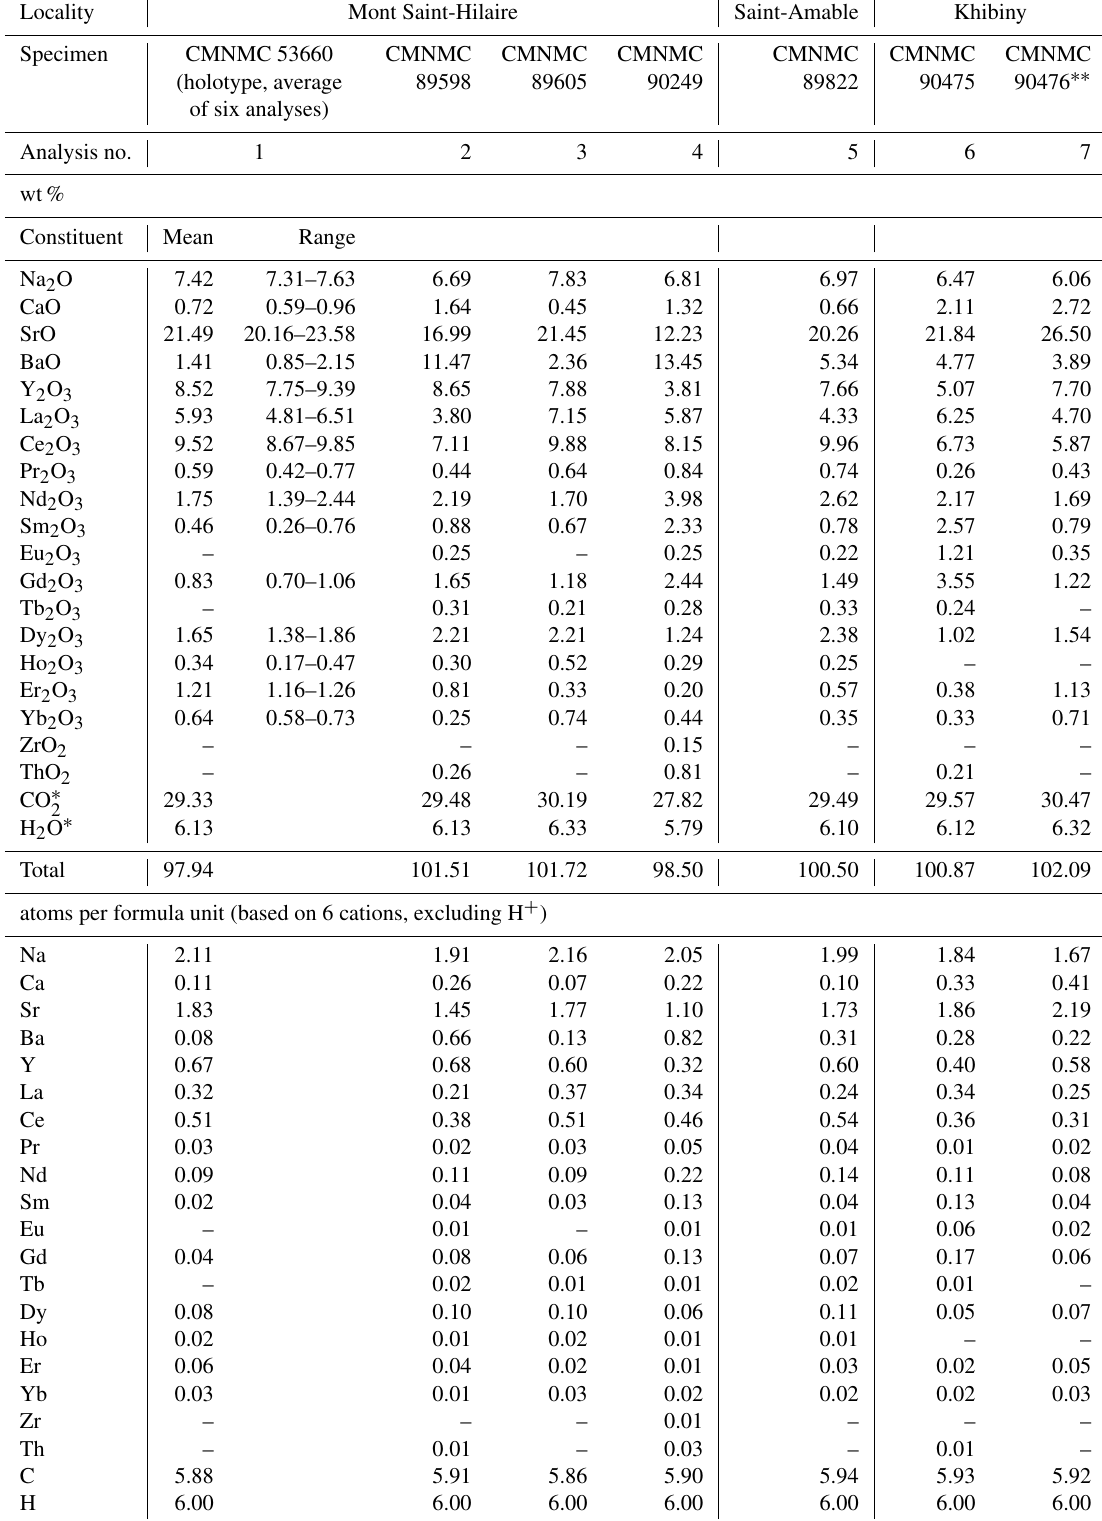
Table 1. Chemical data for alicewilsonite-(YCe). Locality Mont